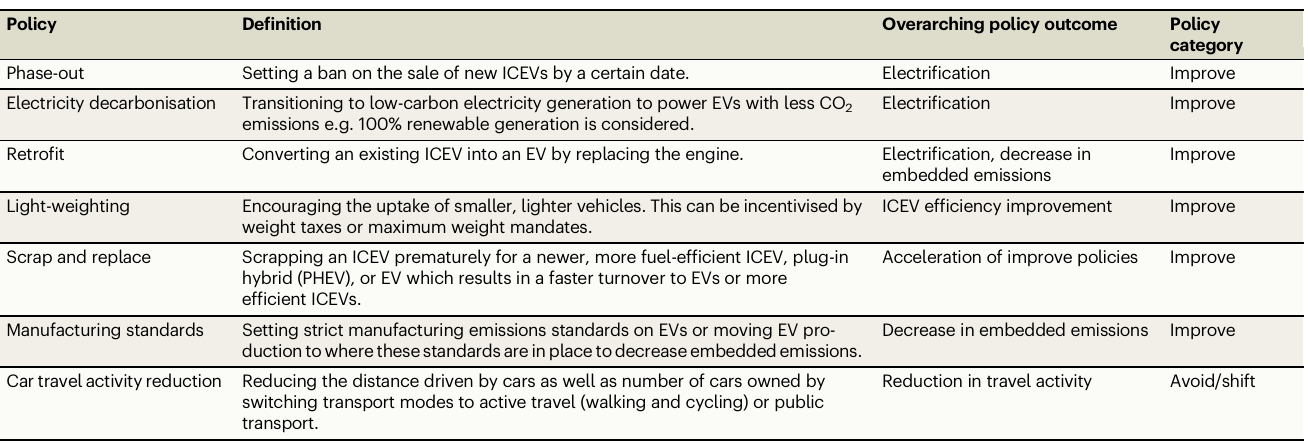
Table 1 | List of policies considered and their details Policy De fi